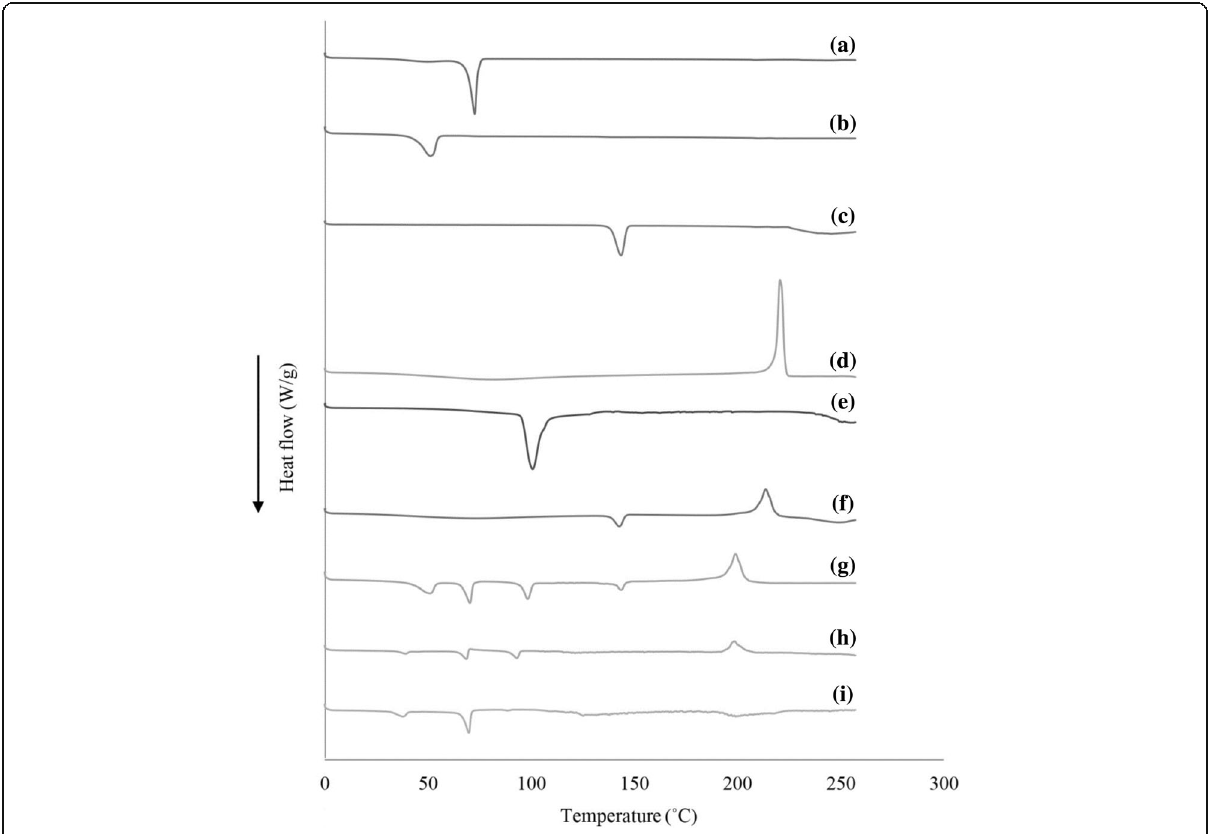
Fig. 8 DSC thermograms of a Compritol 888 ATO, b Polomxamer 188, c verapamil HCl, d dextran sulfate, e trehalose, f verapamil HCl and dextran sulfate physical mixture, g physical mixture (including Compritol 888 ATO, poloxamer 188, trehalose, verapamil, and dextran sulfate), h placebo, and